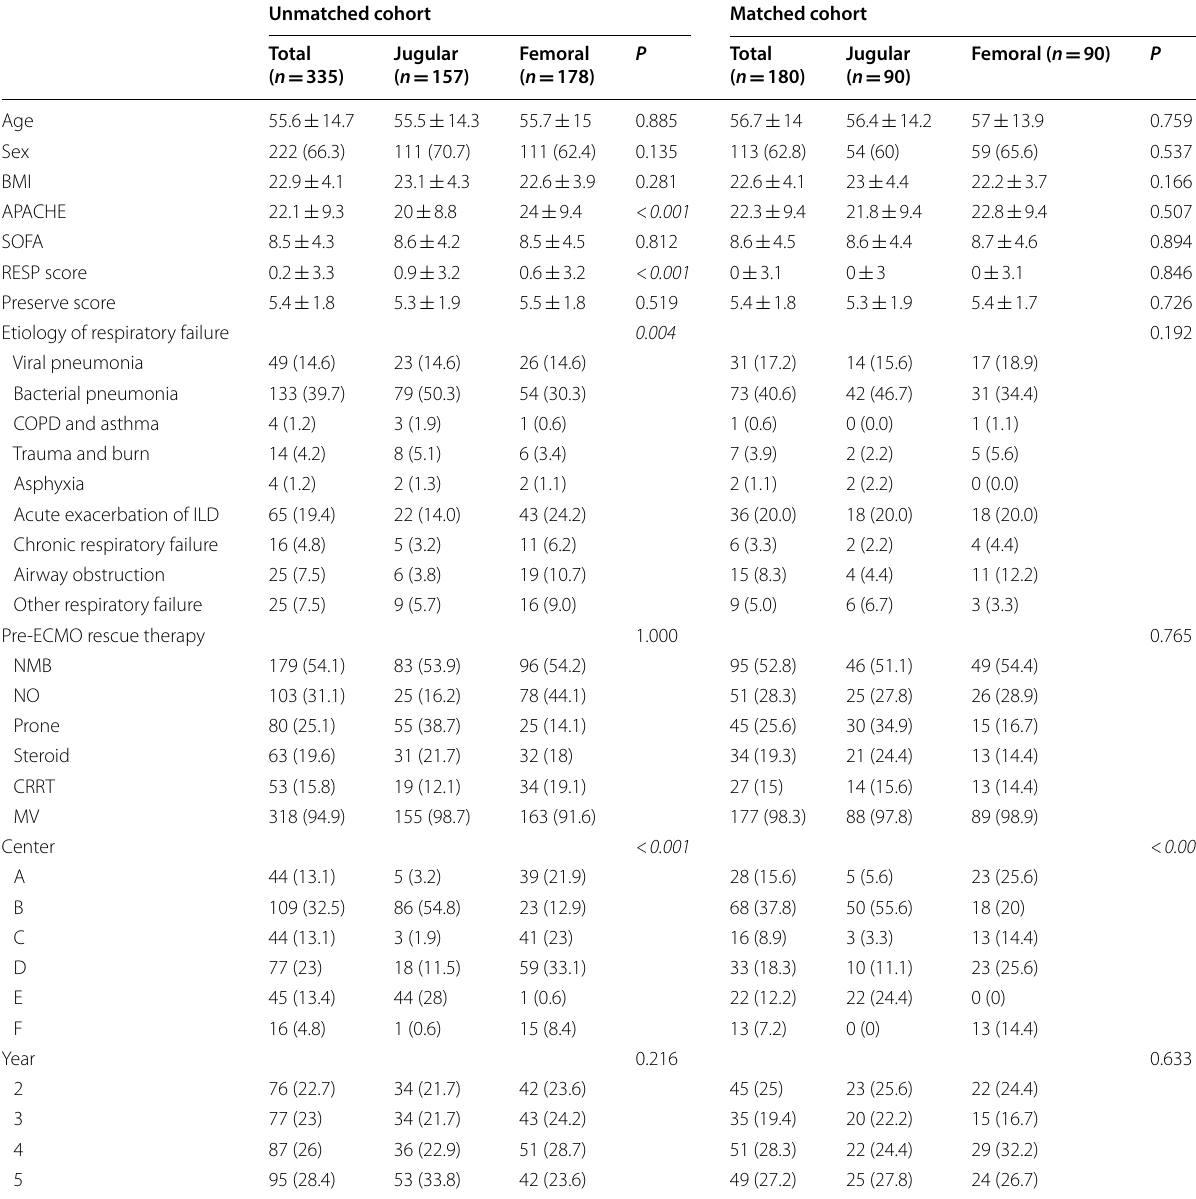
Table 1 Baseline characteristics according to the cannulation (before and after propensity score